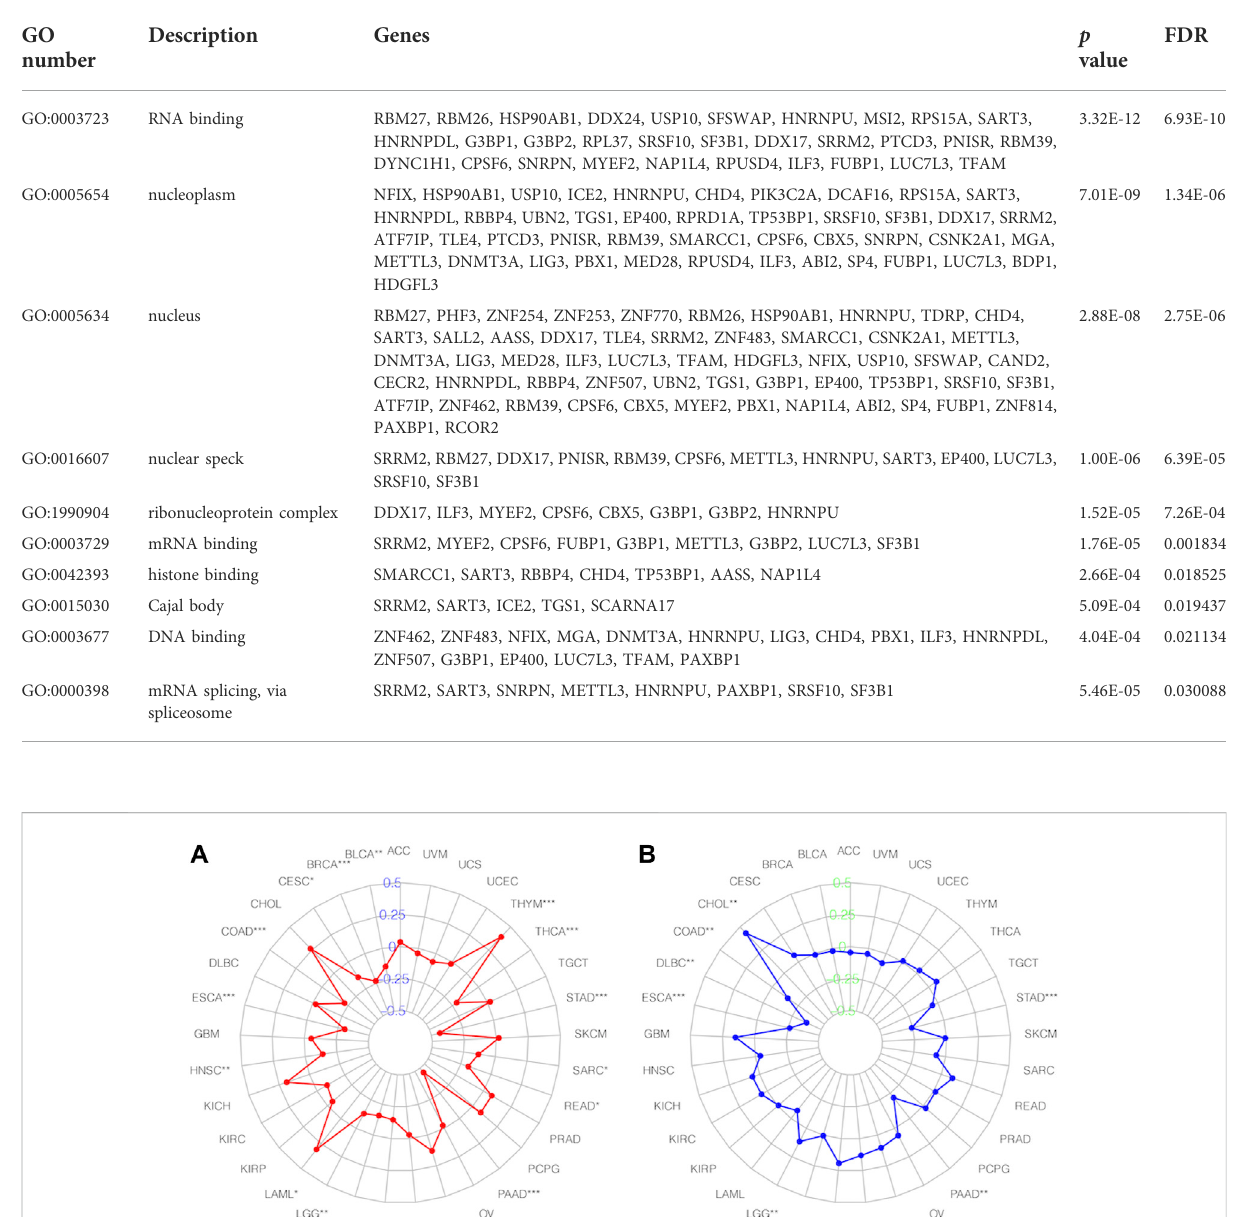
TABLE 4 Summary of FOXP4-AS1 functional roles and related genes.